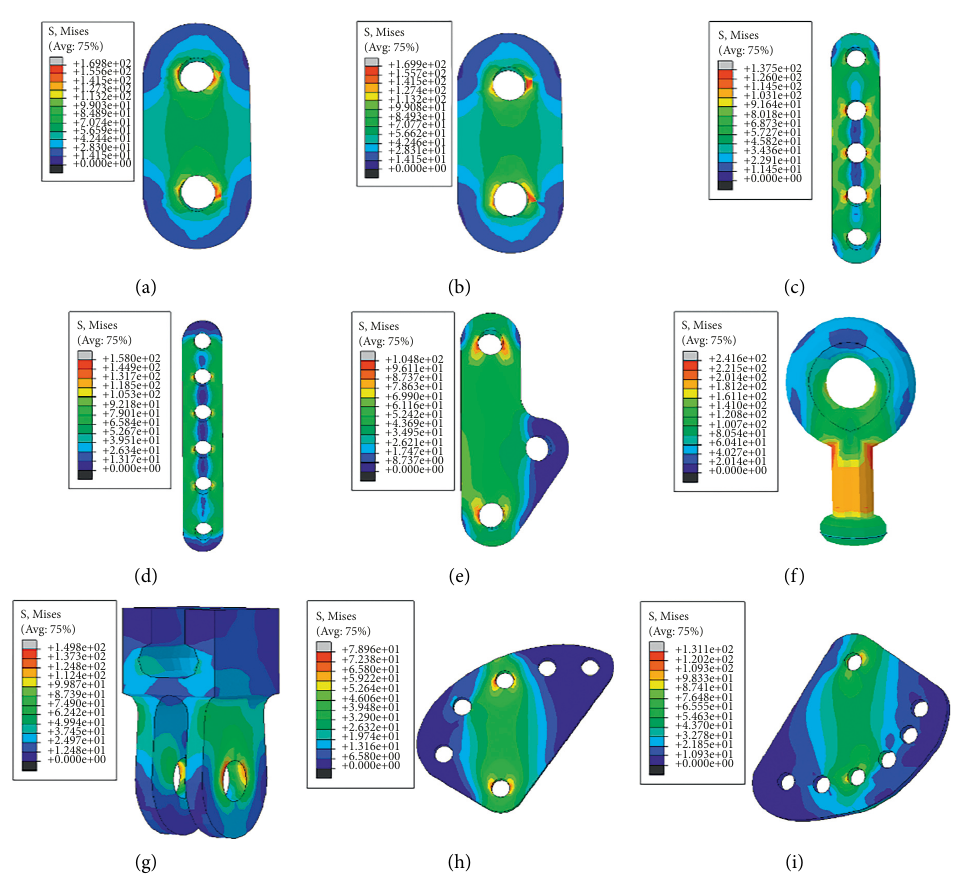
Figure 41: Stress cloud picture of some fittings of tension